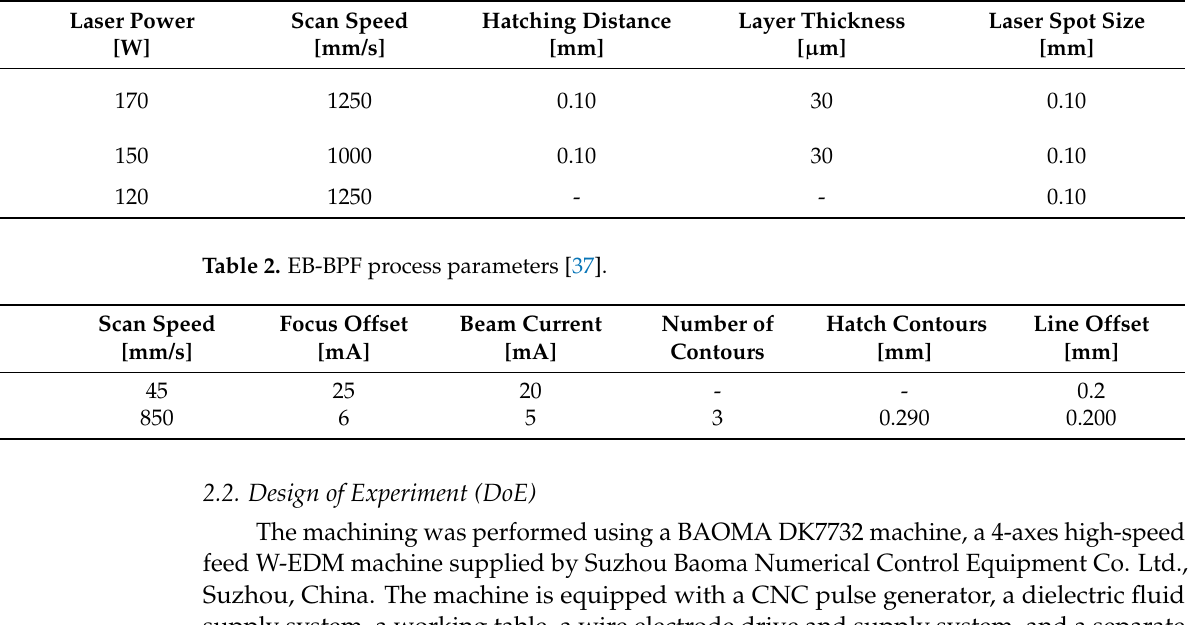
Figure 1. Workpiece geometry and production. Table 1. PBF-LB process parameters [36].